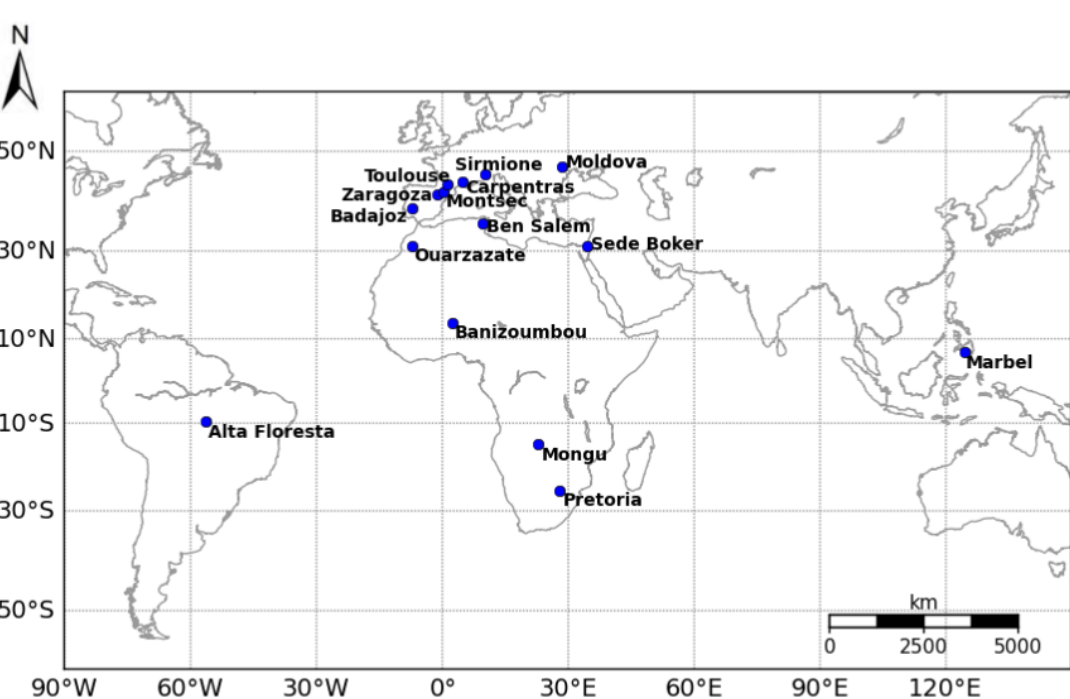
Figure 2. Location of validation